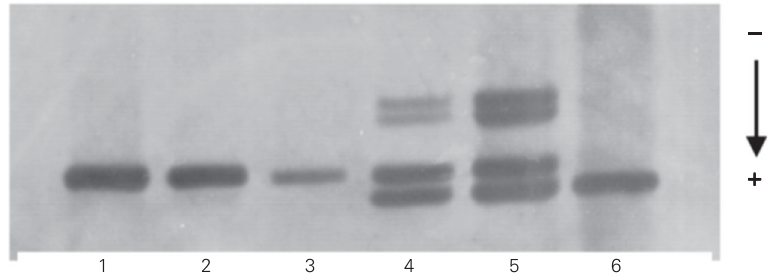
Figure 1. Analysis of the ∆ F508 mutation in 7% polyacrylamide gel stained with AgNO 3 . Individuals 1, 2 and 3 are normal considering the mutation ∆ F508; individuals 4 and 5 are heterozygotes, and individual 6 presents deletion ∆ F508 (affected).